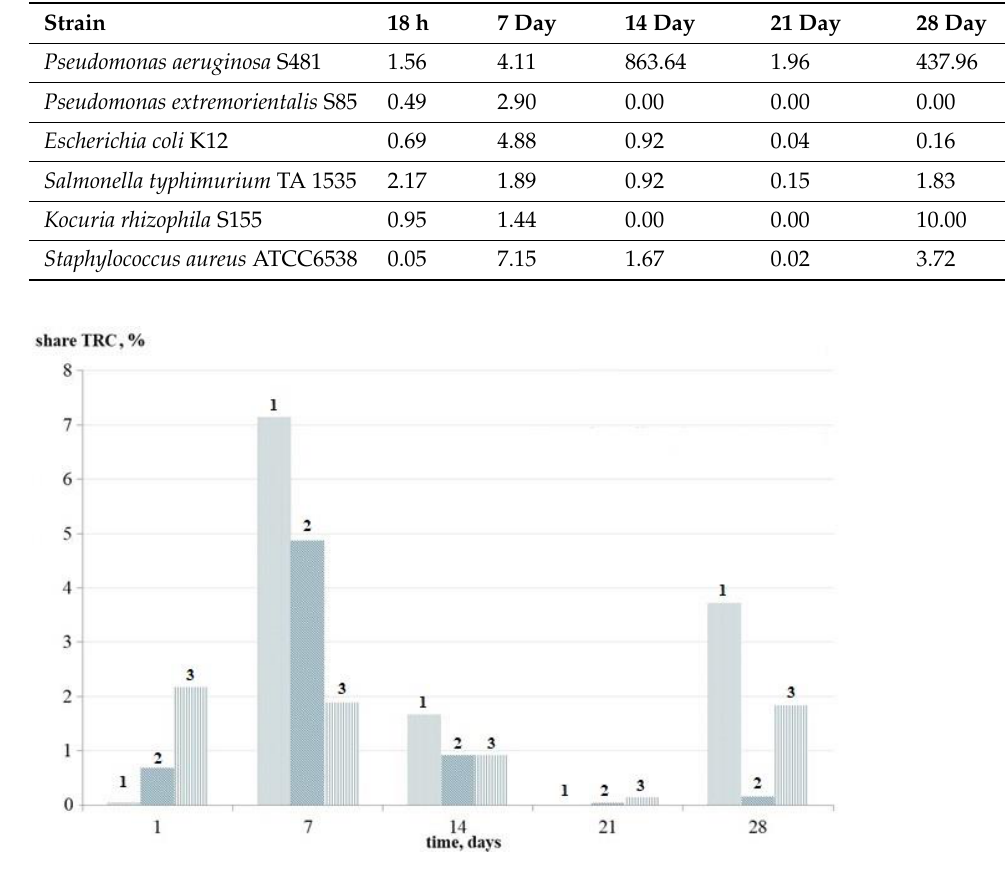
Table 1. Dynamics of changes in the proportion (%) of thermoresistant cells relative to the total number of cells (CFU) in a sample before heating (100%) (in planktonic cultures with agitation). Strain